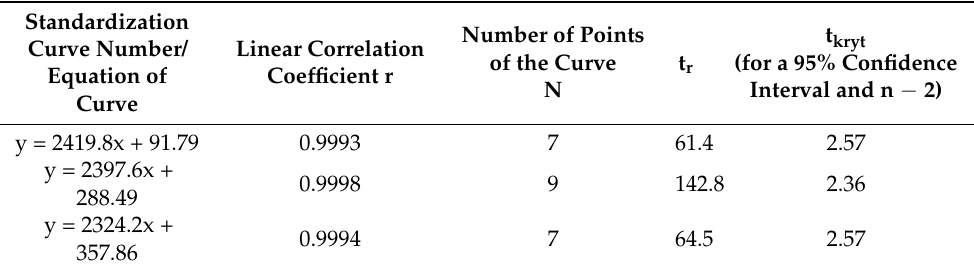
Table 4. Parameters of obtained standardization curves and results of calculations performed to assess